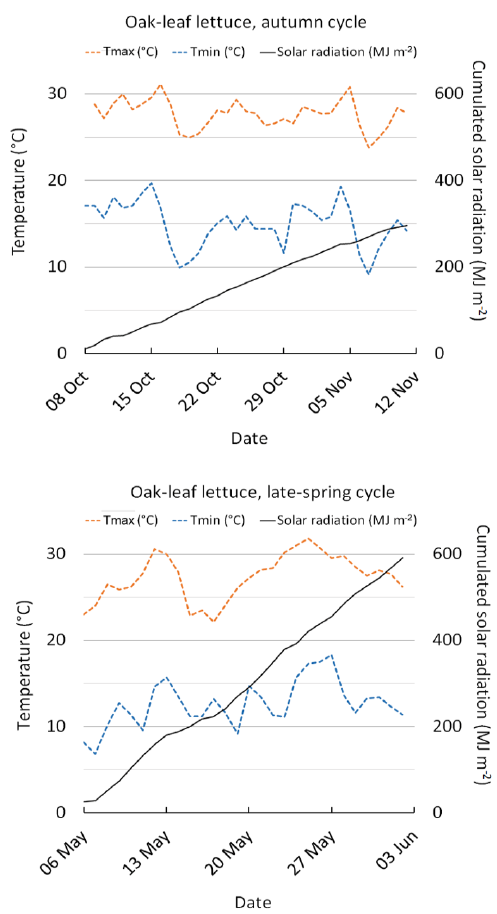
Figure 1. Internal greenhouse minimum and maximum air temperature, and cumulated solar radiation during the autumn and late-spring periods. 2.3. Exp. 2